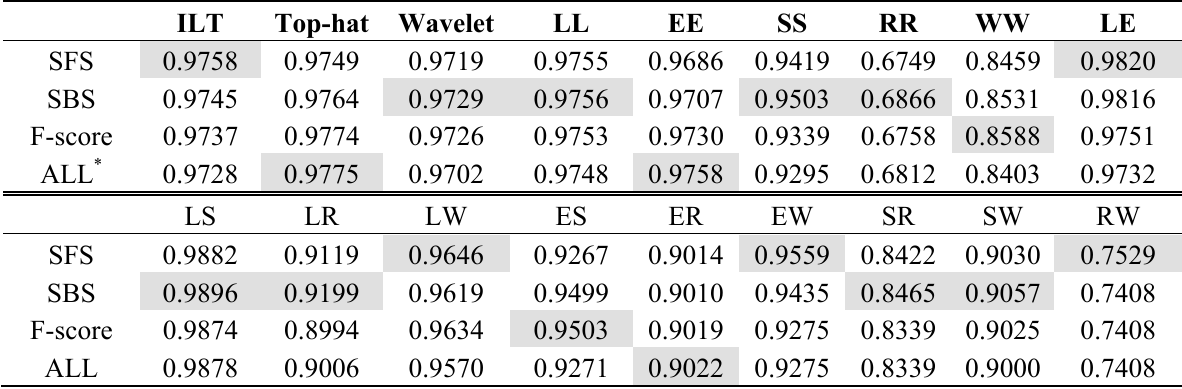
Table 2. Performances of different selection methods with respect to 18 feature images in the training